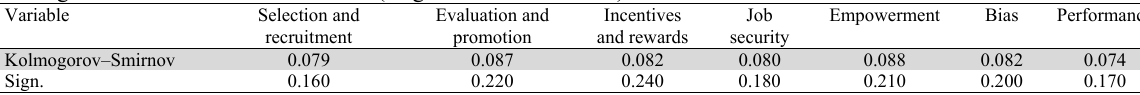
Kolmogorov–Smirnov test value of data (Degree of Freedom = 79) Variable Selection and